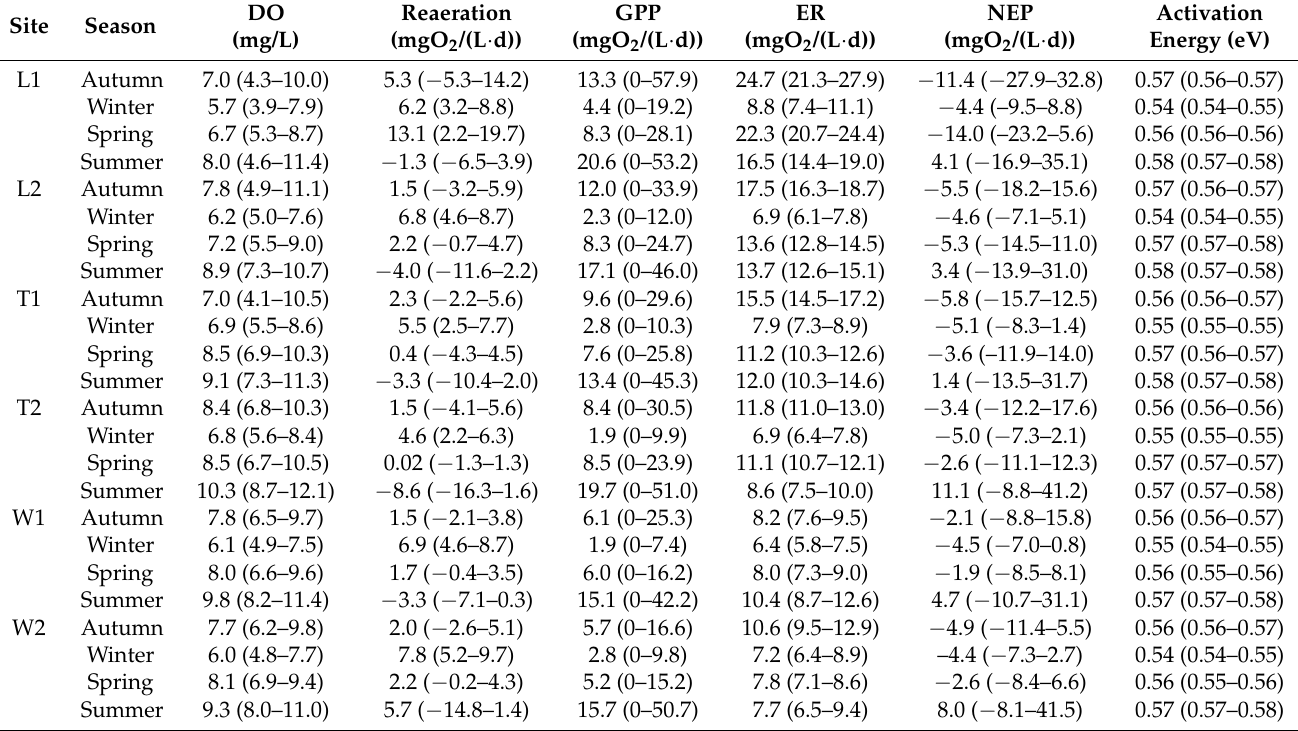
Table 1. Seasonal variation of DO concentrations and river metabolic variables across study